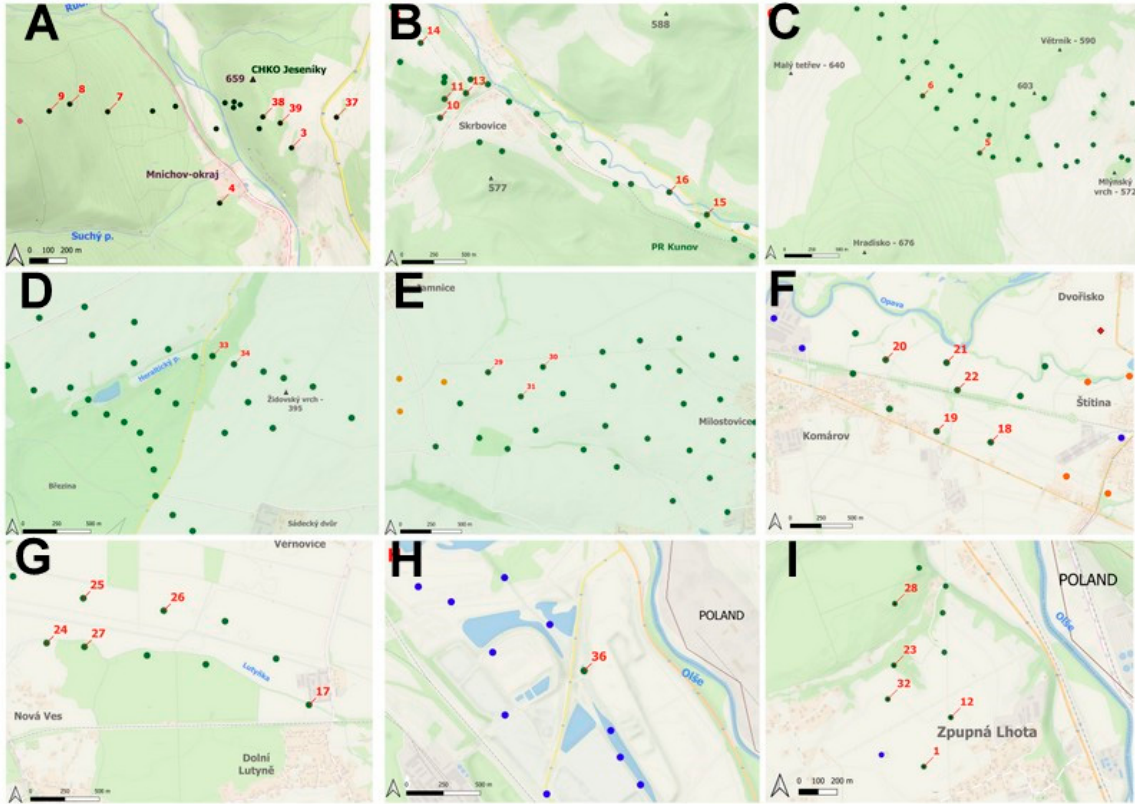
Figure A3. Selected parts of fortification line in Moravian ‐ Silesian Region. Individual parts ( A – I ) are shown in Figure A2. Key: green—Existing A ‐ CEF or UA ‐ CEF; pink—Construction was initiated A ‐ CEF; orange—destroyed A ‐ CEF; blue—obliterated A ‐ CEF; red number—SA ‐ CEF.